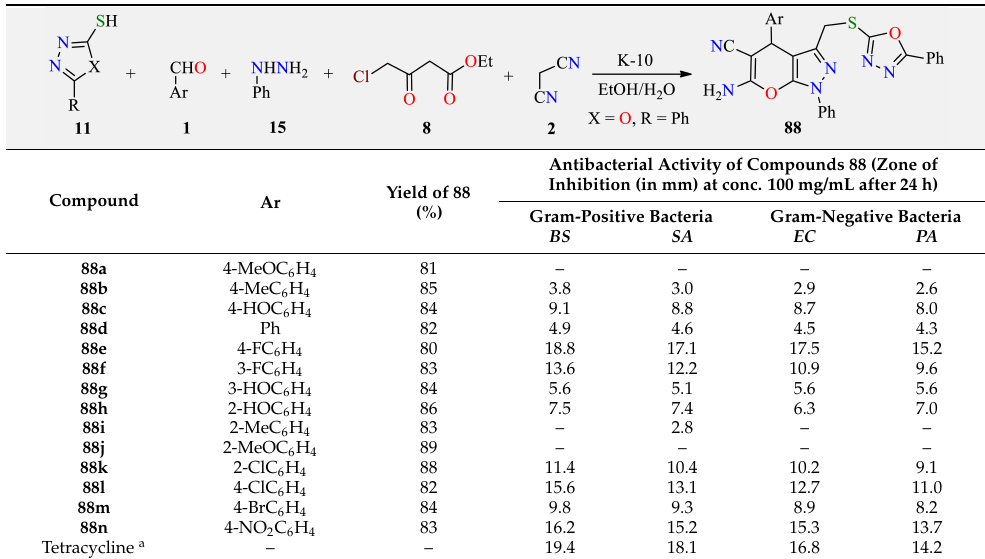
Table 23. Five-component synthesis of dihydropyrano[2,3- c ]pyrazoles 88 and their in vitro antibacte- rial activity against four bacterial